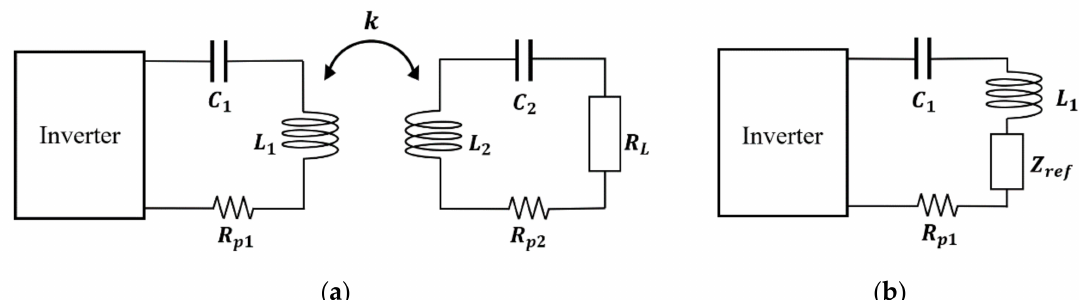
Figure 1. ( a ) The circuit model of a conventional wireless power transfer (WPT) system. ( b ) Equivalent circuit model of the secondary resonator represented by a reflected impedance, Z ref .